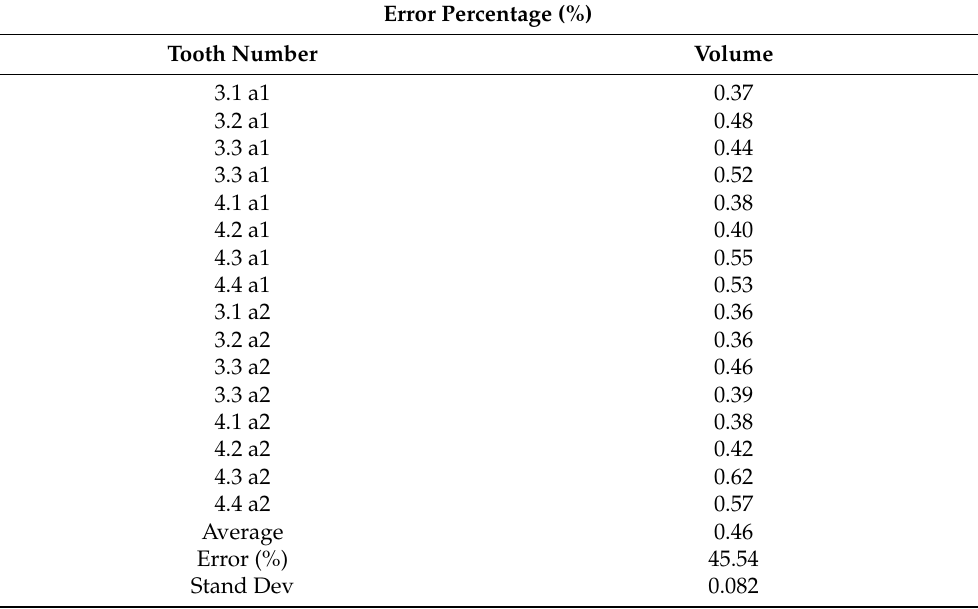
Table 3. Assessment of the percentage error calculated by evaluating the difference between the volume of the natural tooth and the prototyped tooth. For problems of a technical nature, the top third of the models was reduced and this justified its high error percentage. (see Figure